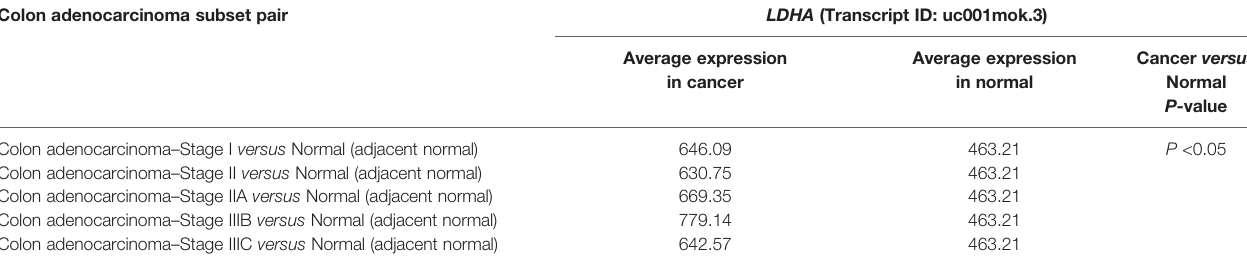
TABLE 1 | The expression of LDHA in TCGA COAD RNA-seq dataset were analyzed by the Cancer RNASeq Nexus. Colon adenocarcinoma subset pair LDHA (Transcript ID: